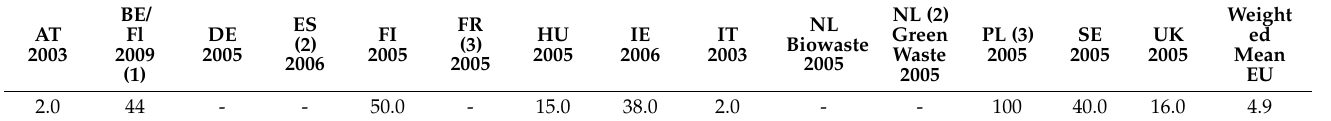
Figure 1. The samples of valuable compounds from biodegradable waste that can be used for degraded soil remediation/revitalization. Table 2. Land restoration and landfill cover use of compost (%) in major compost producing EU countries [15].